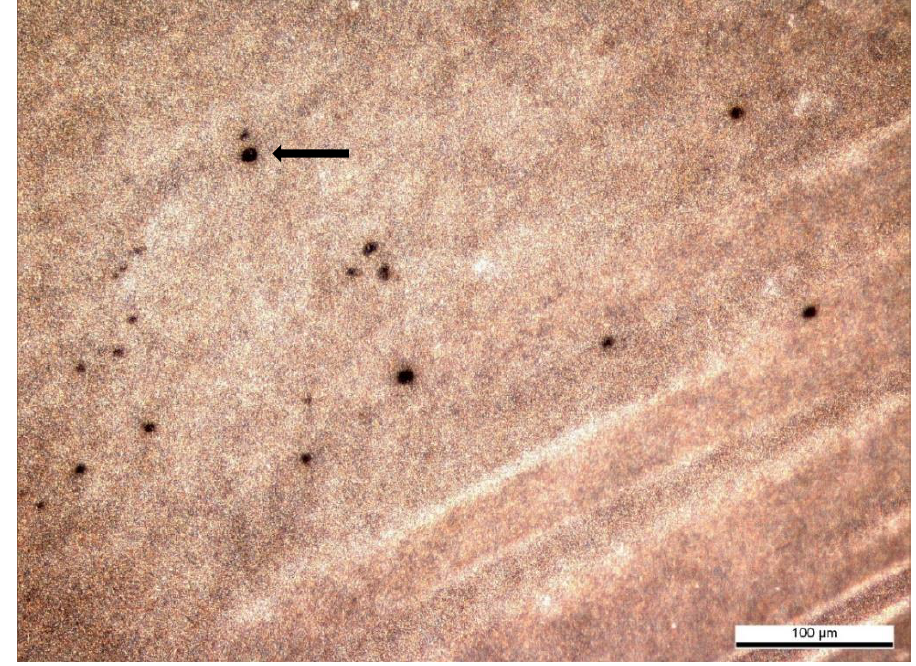
Figure 2. Holes in the chicken IPVM produced by penetrating frozen–thawed cock spermatozoa ( × 100). The relationship between the sperm concentration (fresh sperm / cock) and median number of holes was statistically significant (r s = 0.720, p = 0.0125). The number of holes found in the pieces of perivitelline membrane incubated with fresh and frozen–thawed cock spermatozoa are shown in Table 5. Table 5. Results of the IPVM penetration assay with fresh and frozen – thawed cock spermatozoa (n = pieces of IPVM) are shown below. Ejaculate No.